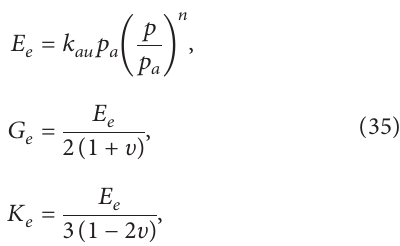
p for constant stress increment ratio